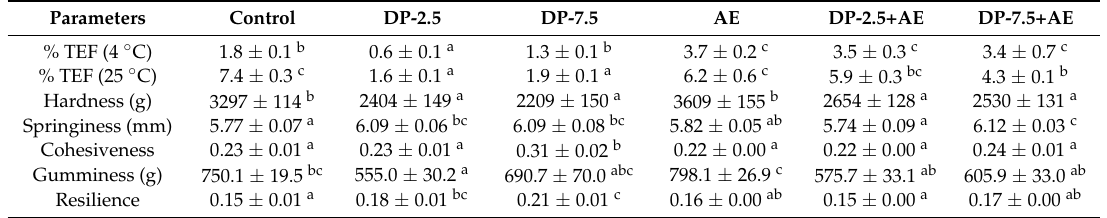
Table 3. Emulsion stability measured as total expressible fluid (% TEF) at 4 and 25 ◦ C, and textural properties of the different p â t é s with date paste (DP) (0%, 2.5%, and 7%) and annatto extract (AE) (0 and 128 mg/kg) (Mean ±